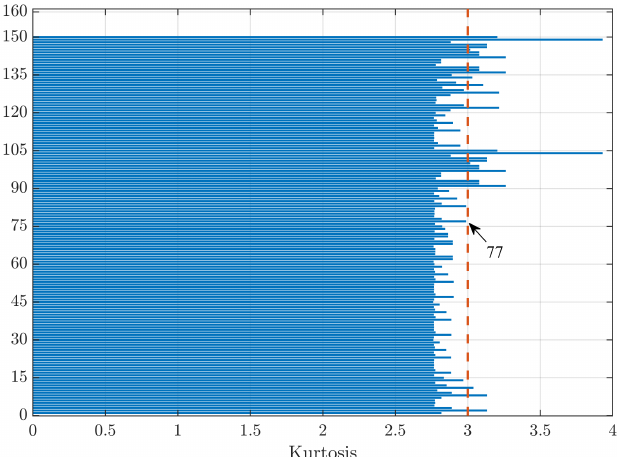
Figure 12. Comparison of the kurtosis values for a healthy bearing. The dashed orange line indicates the wanted kurtosis value in the case of healthy bearings equal to 3.